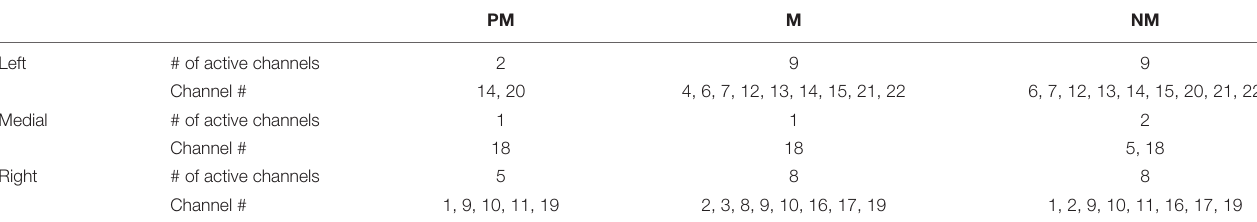
TABLE 4 | Significantly active channels and corresponding brain regions for each condition at the group level. PM M